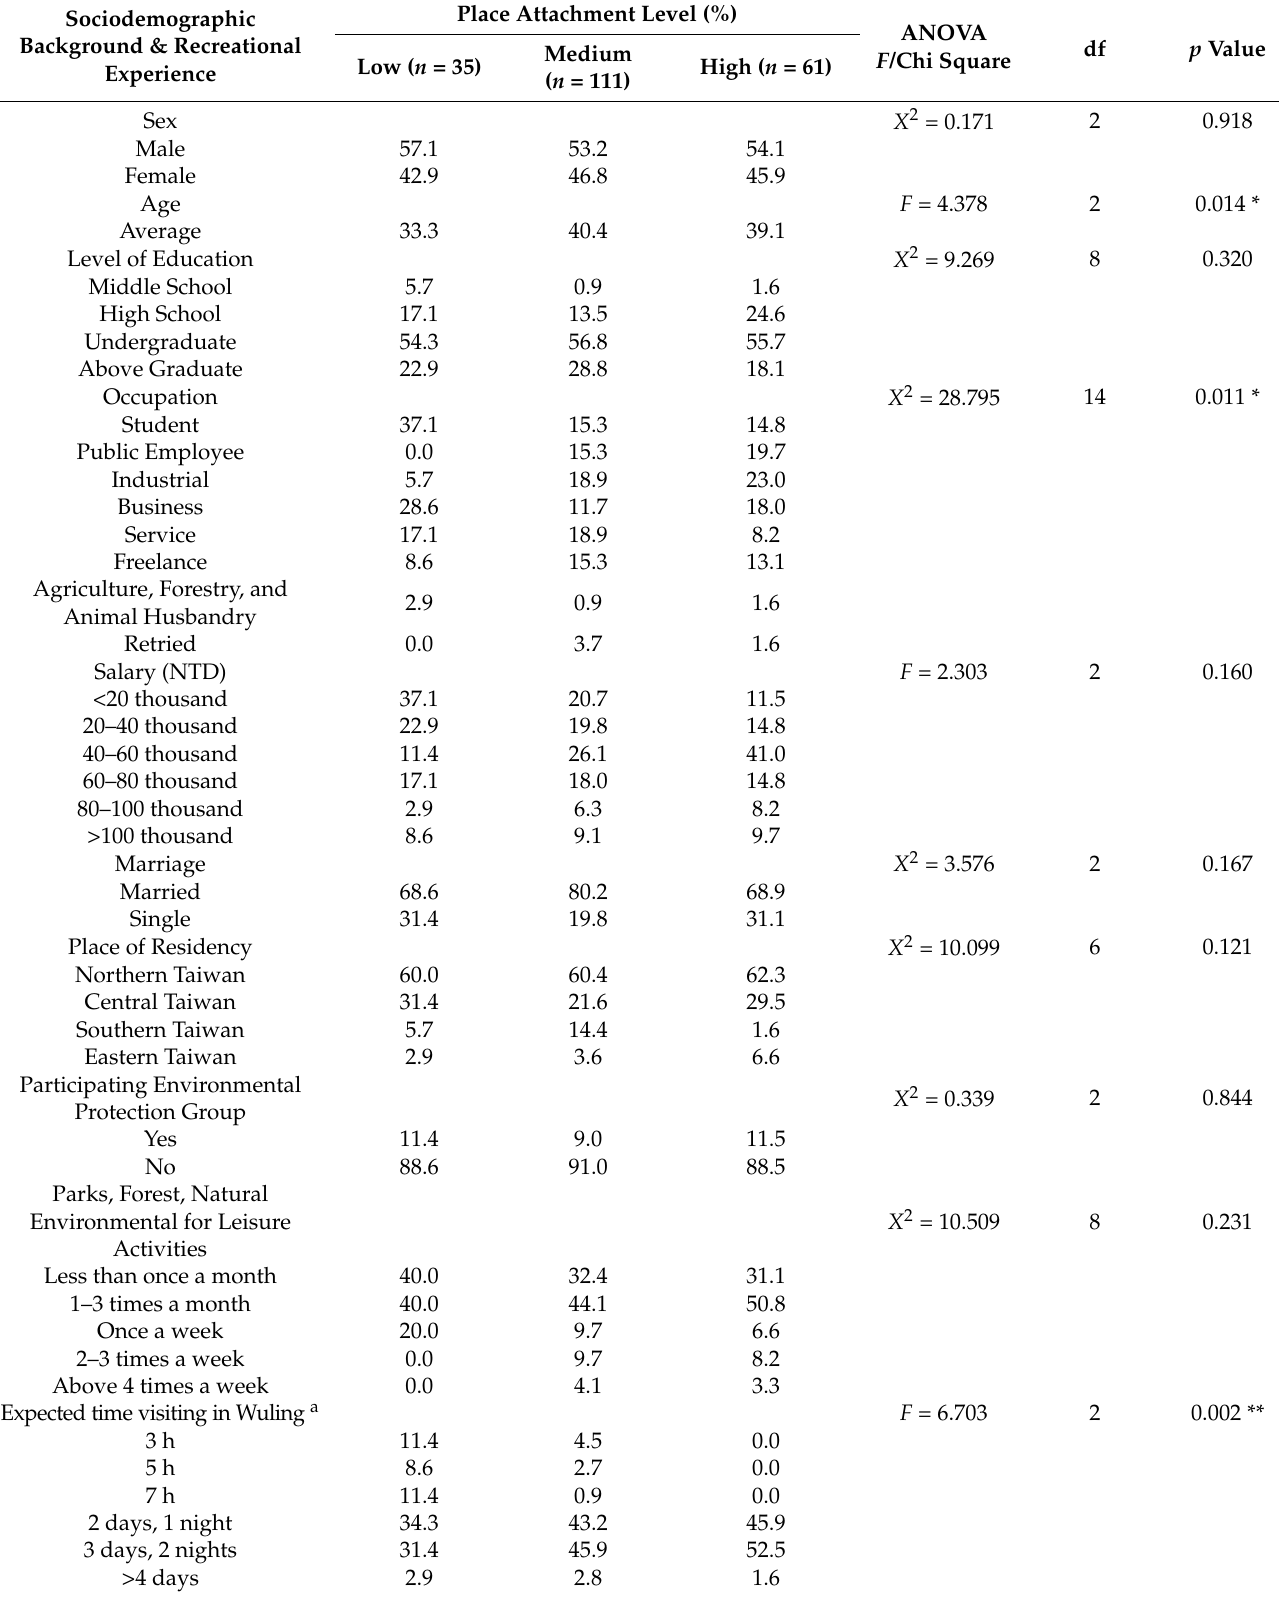
Table 7. Sociodemographic background and recreational experience based on place-attachment clusters.